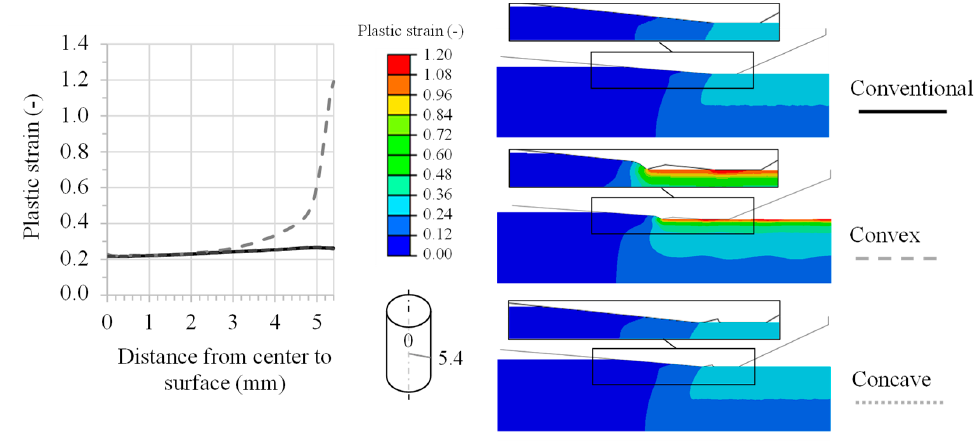
Figure 7. FE simulation of wire drawing—plastic strain over the specimen cross-section.